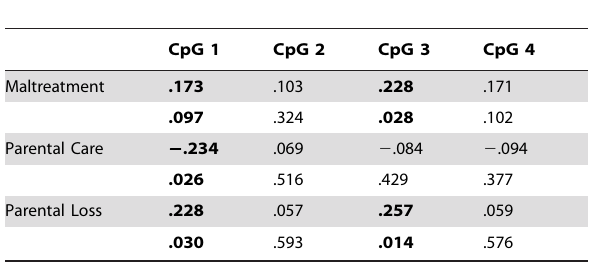
Table 1. Associations of Childhood Adversity Measures and Percent Methylation at Hypothesized CpG Sites